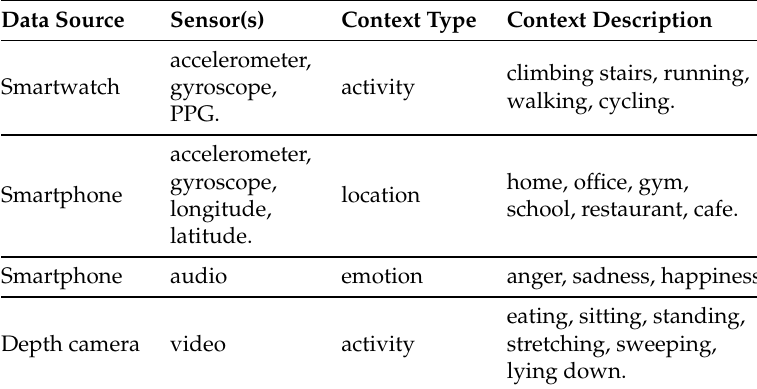
Table 1. Multimodal raw sensory data